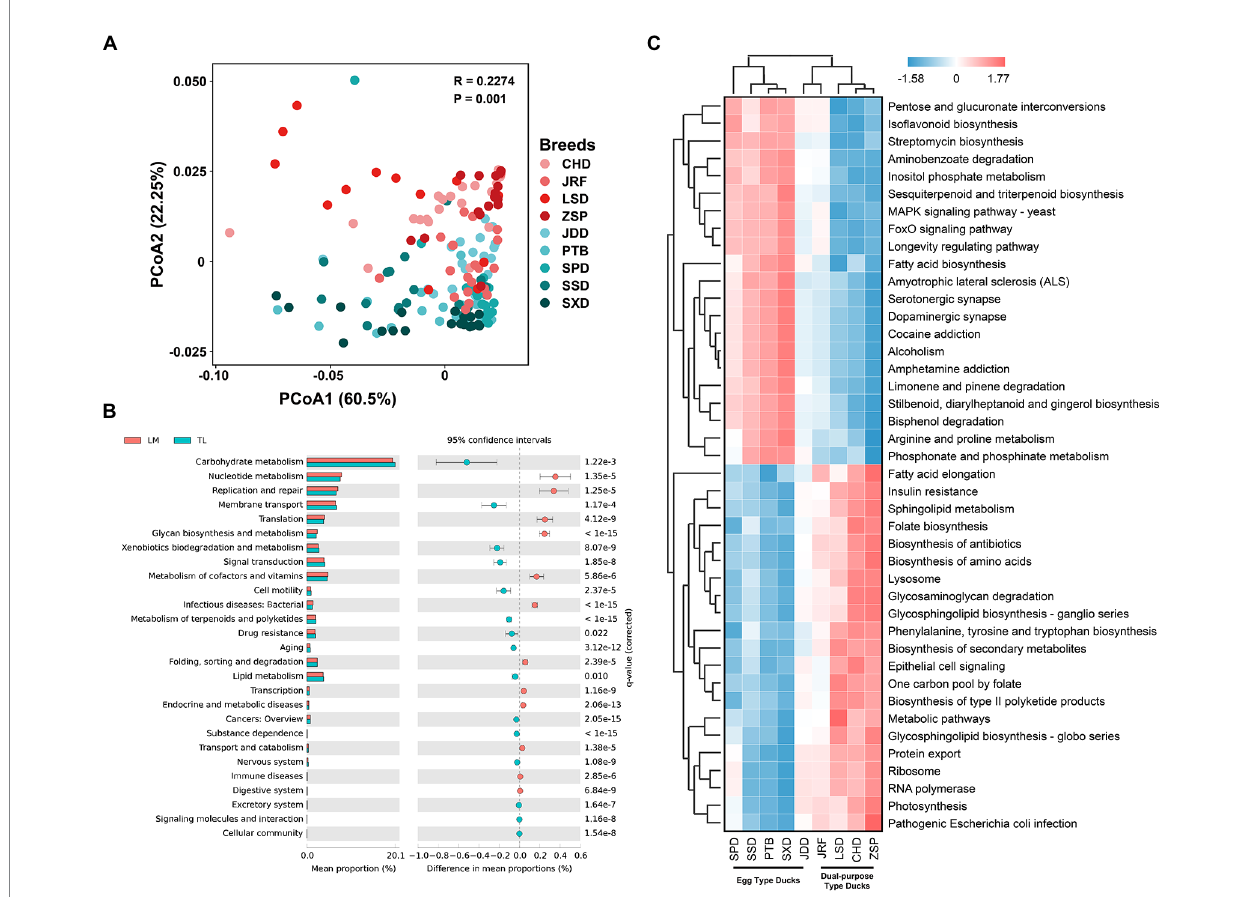
FIGURE 7 Fecal microbial functional prediction using Tax4Fun. (A) Principal coordinate analysis (PCoA) of fecal microbial functions. (B) Differences in fecal microbial function between the dual-purpose and egg type ducks based on Kyoto Encyclopedia of Genes and Genomes (KEGG) secondary metabolic pathways. (C) Heatmap of KEGG Orthology significantly enriched in fecal microbiota of dual-purpose and egg type ducks. Welch’s t-test and Storey’s methods were used for multiple tests